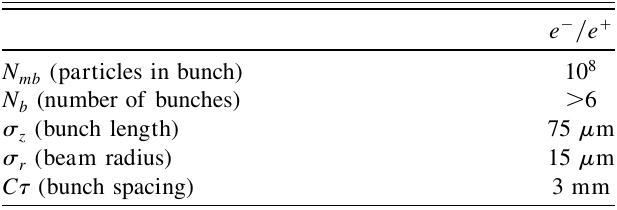
FIG. 1. (Color) Model problem.Wakefields in the plasma from some of the bunches are used to accelerate the others. The dotted line indicates the ‘‘spent’’ bunches. In this figure the even bunches (blue) in a four bunch train are accelerated by the wakes of the odd bunches (red). TABLE I. Bunch train